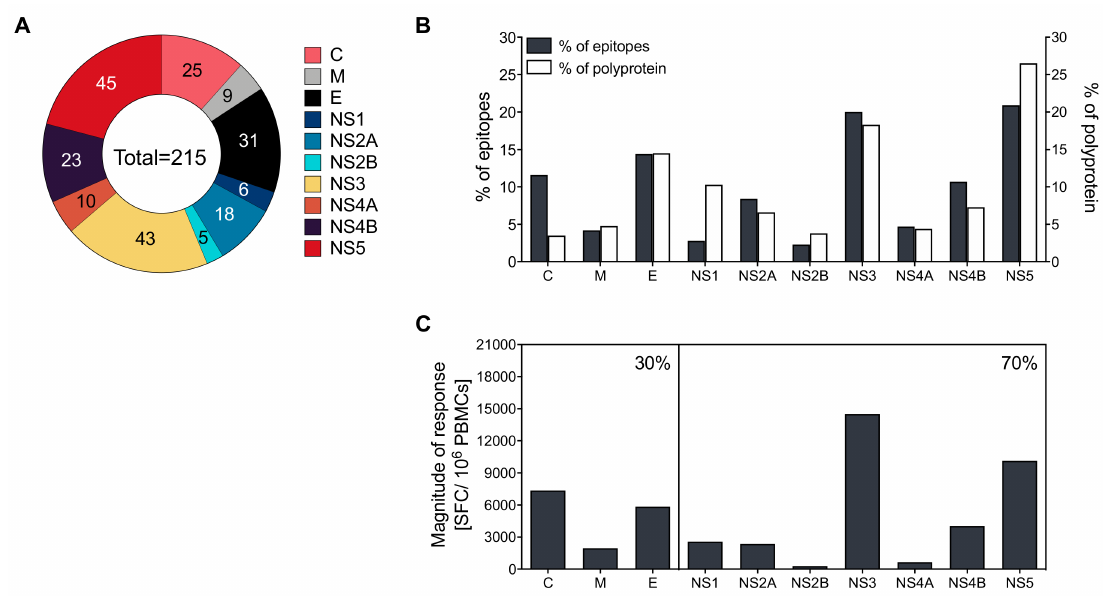
Figure 1. Protein location and magnitude of response of CD4 + epitopes identified. ( A ) Patterns of protein immunodominance of CD4 + T cells responses against yellow fever virus (YFV) epitopes. The fraction of identified epitopes is plotted as a function of the protein they are derived from (capsid protein [C], membrane protein [M], envelope protein [E], non-structural protein 1 [NS1], NS2A, NS2B, NS3, NS4A, NS4B, and NS5). Numbers represent the number of epitopes identified. ( B ) Relative distribution of epitopes derived from the structural (C, M, and E) or NS proteins (NS1–5). The gray bars reflect a relative number of peptides for each protein predicted to bind the various HLA-DR molecules, and the white bars show the percentage of all possible peptides (percentage of the YF-17D polyproteins) accounted for by each antigen. ( C ) The magnitude of response per structural (C, M, and E) or NS proteins (NS1–5). The magnitude of response was defined as the average sum total of spot-forming cells (SFCs) / donor associated with each protein. Percentages in the upper right corner reflect the relative response directed at either structural or NS protein